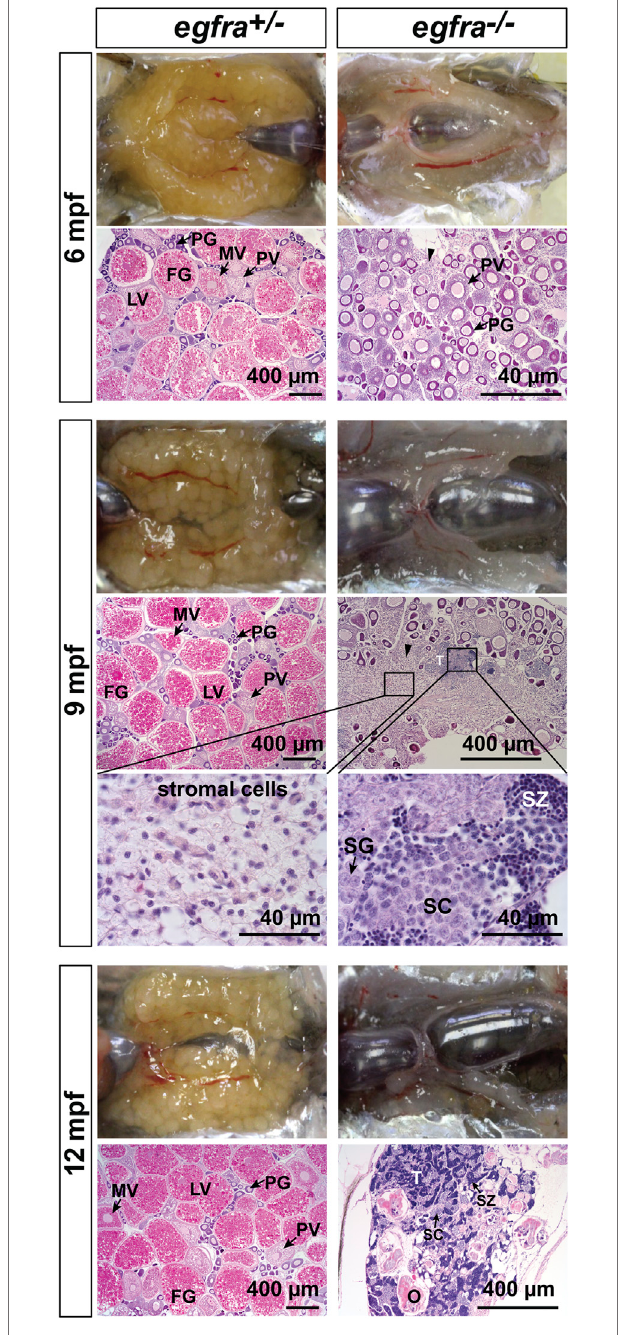
FIGURE 9 | Progressive degeneration of follicles and sex reversal to malesin egfra − / − females. Folliclesin egfra − / − ovariesunderwentprogressive degenerationfrom6to12 mpf.Whilethefolliclesweredegenerating,theinter- follicular spaces were gradually occupied by somatic stromal cells, an early sign of masculinization. Testicular tissues with spermatogenic cells started to appear at 9 mpf and increased progressively afterward. By comparison, the ovaries of control egfra +/ − females were fi lled with follicles of all developmental stages from PG to FG during the period. PG, primary growth; PV, previtellogenic; MV, mid-vitellogenic; LV, late vitellogenic; FG, full- grown; SG, spermatogonia; SC, spermatocytes; SZ, spermatozoa; T, testis tissue; O, degenerating